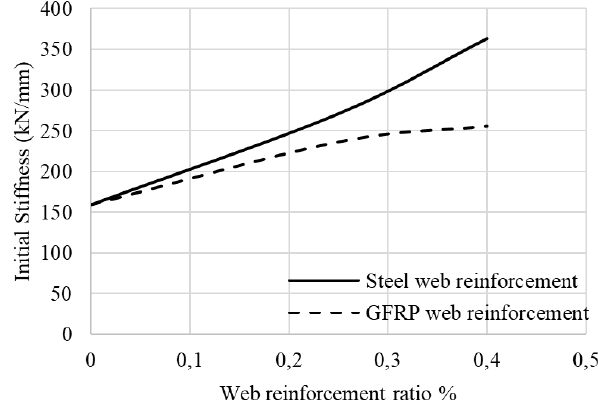
Figure 11: Relation between initial stiffness and web reinforcement